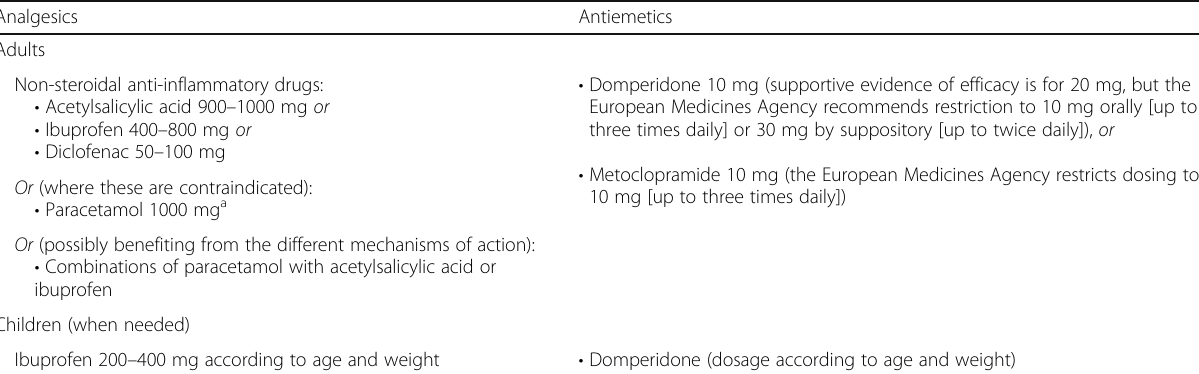
Table 7 Recommended drugs and doses for acute migraine therapy, step one